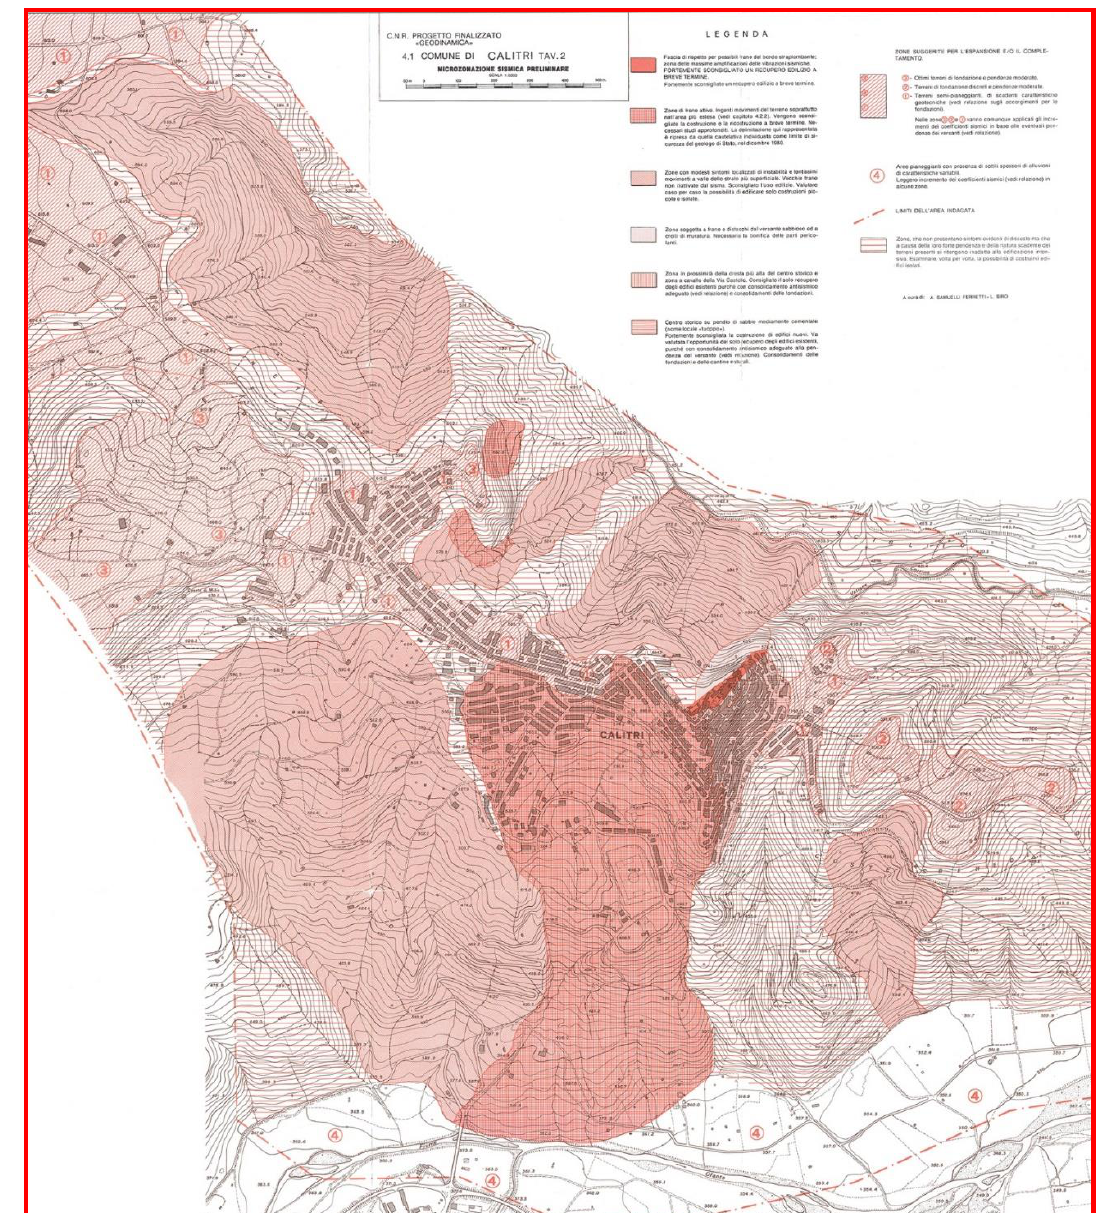
Figure 110. Original map of the seismic microzonation of Calitri according to [29].